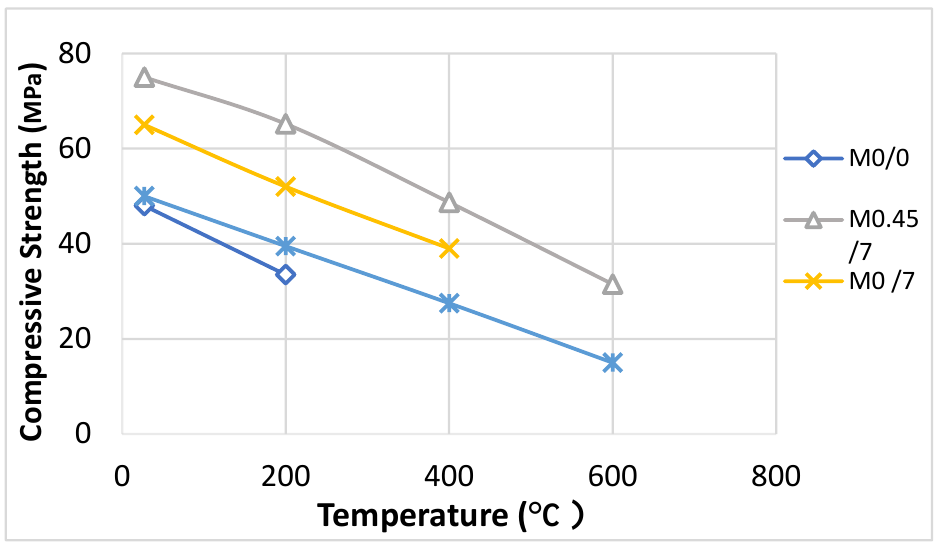
Figure 11. Effect of high temperatures on the residual compressive strength of all concrete speci- mens.